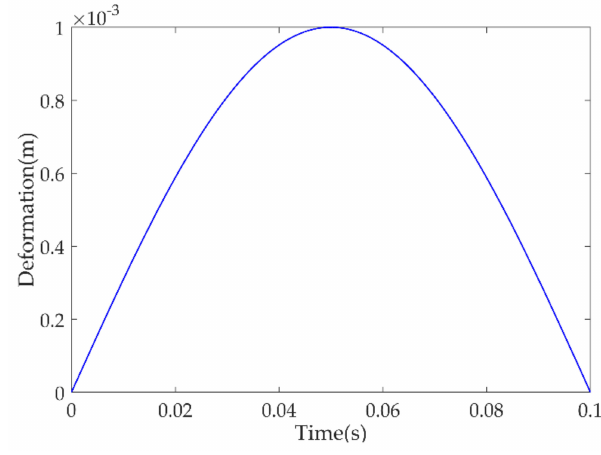
Figure 4. Schematic diagram of collision deformation.